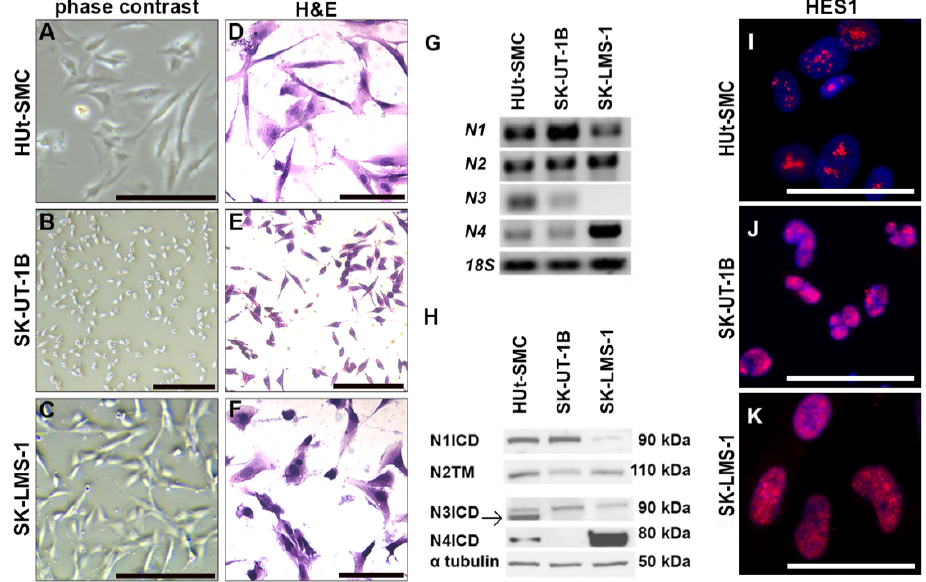
Figure 3. Notch expression in cell lines. ( A – C ) Representative phase contrast images of each cell line. ( D – F ) Representative H&E stained images of each cell line. ( G ) mRNA expression of NOTCH genes (N = NOTCH) by RT-PCR. 18s rRNA was loading control. HUt-SMC and SK-UT-1B expressed N1 , N2 , N3 , and N4. SK-LMS-1 cells expressed N1 , N2 , and N4 , and minimal N3. ( H ) Expression of NOTCH proteins (N = NOTCH) by Western Blot. α -tubulin was loading control. N1ICD, N3ICD and the N4ICD were expressed in HUt-SMC, indicative of active Notch signaling. The transmembrane region of NOTCH2 (N2TM) was expressed in HUt-SMC. Expression of N2TM demonstrated expression of NOTCH2 protein, but not NOTCH2 signaling activity in HUt-SMC. SK-UT-1B cells expressed N1ICD. SK-LMS-1 expressed N4ICD. The antibody used to detect N3ICD yielded non-specific signals in SK-UT-1B and SK-LMS-1. ( I – K ) Representative images of immunostaining for HES1. Scale bars = 200 µm in ( A , C ); 100 µm in ( B,D – F ); and 50 µm in ( I – K ).